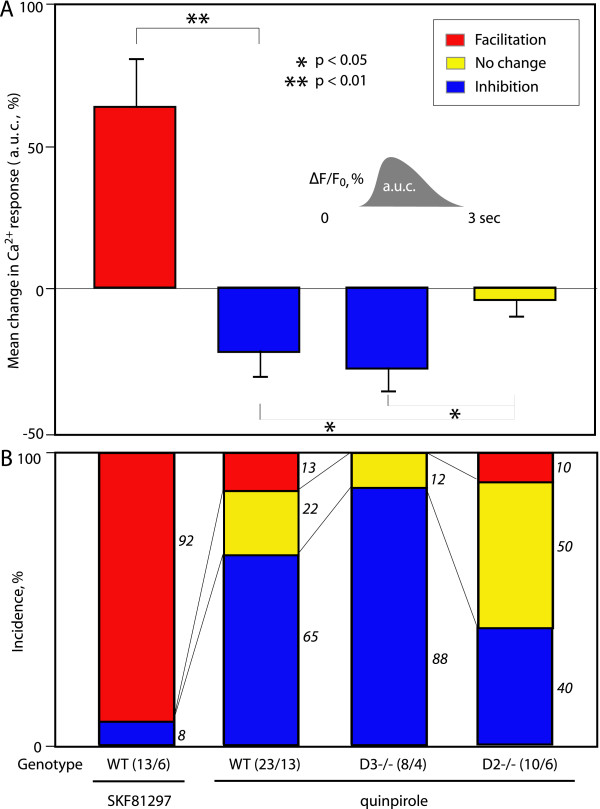
Summary of DA receptor agonist modulation in wild type and DA receptor KO mice. A. The mean change in Ca2+ responses is shown for the full data set (bars are colored to indicate main effect). Asterisks mark significant differences. The quinpirole inhibition seen in WT and D3 KO mice was completely abolished in D2 KO mice (p < 0.05). B. The incidence of DA modulation was assessed using the 5% criterion (see text). Numbers in parentheses indicate the total number of varicosities and cells recorded, respectively. While D1 stimulation with SKF81297 produced facilitation in almost all instances, D2 stimulation with quinpirole produced both inhibition and facilitation. Quinpirole facilitation seen in WT and D2 KO mice was completely abolished in D3 KO mice.